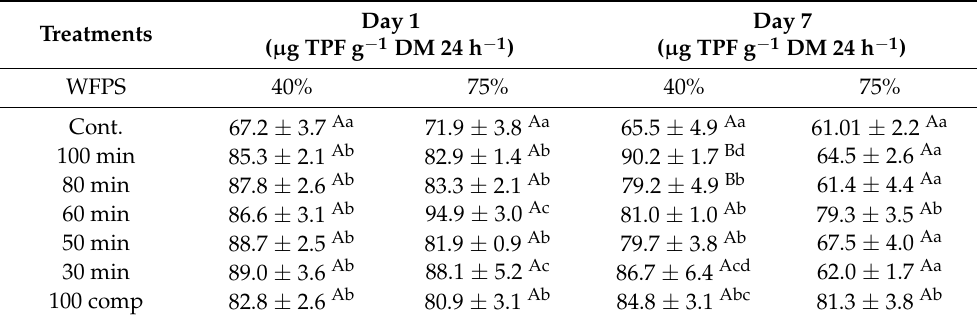
Table 6. Dehydrogenase activities in different fertilizer types and water-filled pore space (WFPS; 40% and 75%) (N = 3) (Mean ± standard